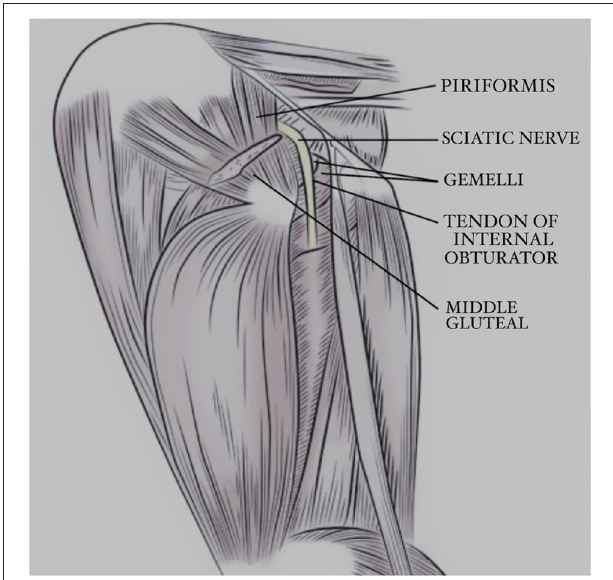
FIGURE 1 | Illustration of the anatomy of the deep gluteal region in a dog, lateral view. Courtesy by Clean Run Magazine.